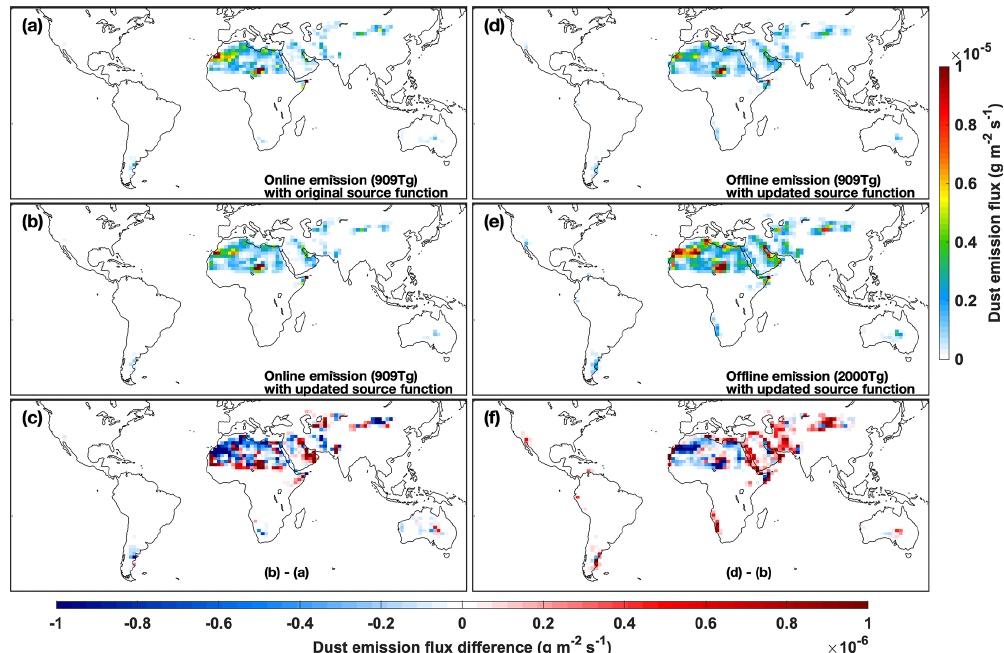
Figure 2. Annual mean dust emission flux rate for 2016. (a) The original online dust emissions with original dust source function and annual total dust emissions of 909Tg. (b) Online dust emissions with updated dust source function. (c) Difference of flux rate between online dust emissions using original and updated dust source functions. (d) Offline dust emissions with updated dust source function. (e) Offline dust emissions with updated dust source function and updated annual total dust emissions of 2000Tg. (f) Difference of flux rate between offline and online dust emissions. The online dust emissions are in 2 ◦ × 2.5 ◦ resolution. The offline dust emissions shown in (b, d, f) are regridded from 0.25 ◦ × 0.3125 ◦ resolution to 2 ◦ × 2.5 ◦ for comparison with online dust